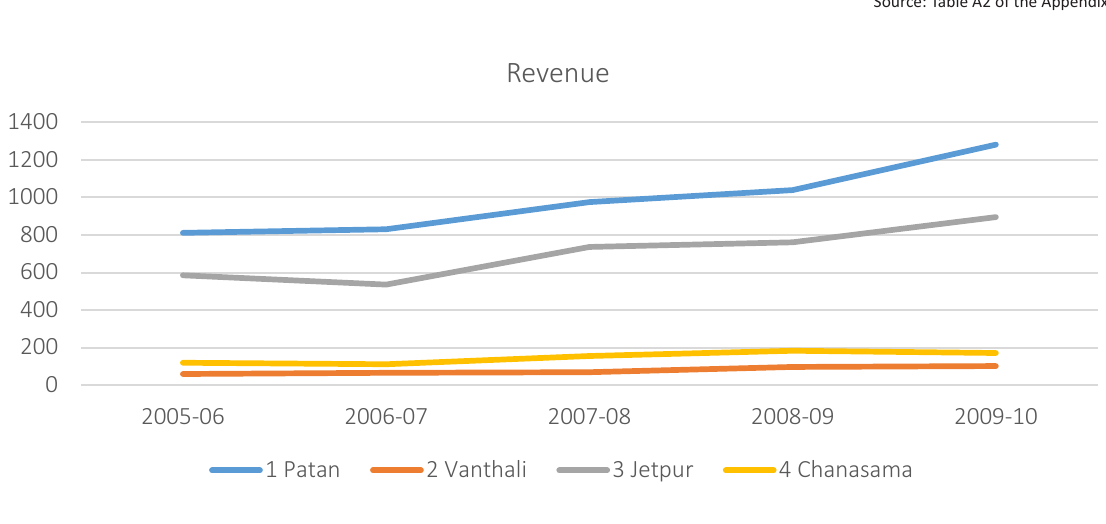
Figure 2. Revenue expenditure across municipalities in Gujarat